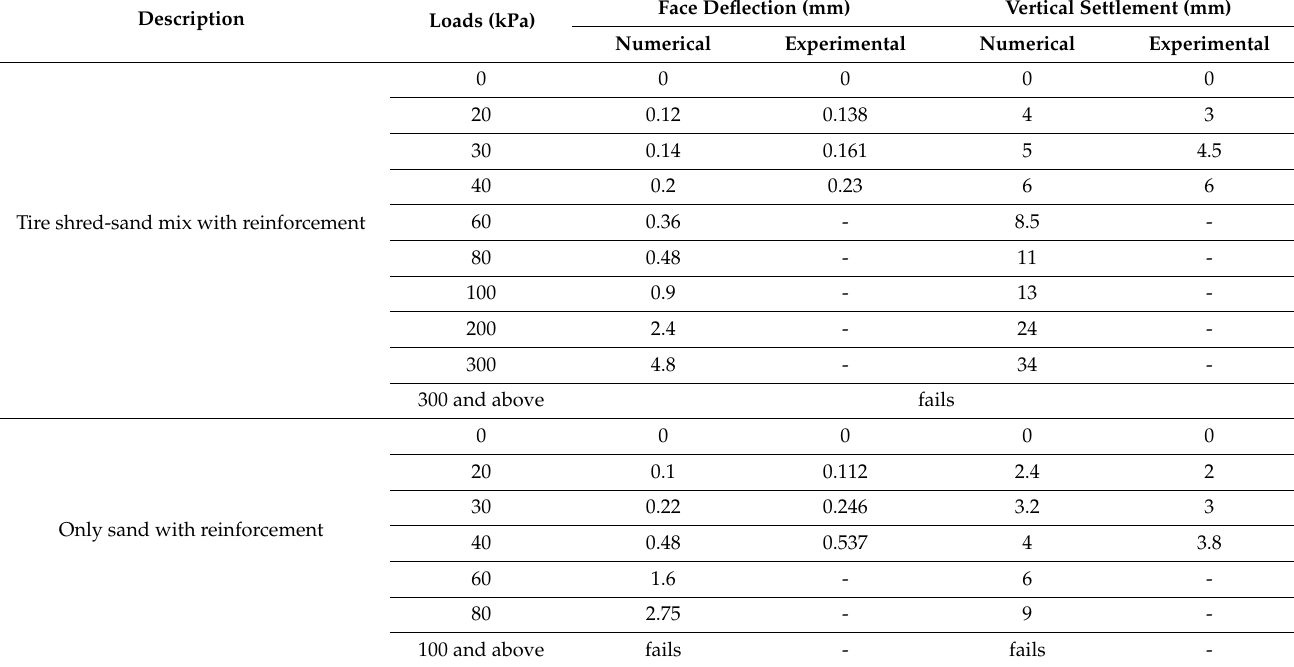
Table 6. Comparison of numerical and experimental